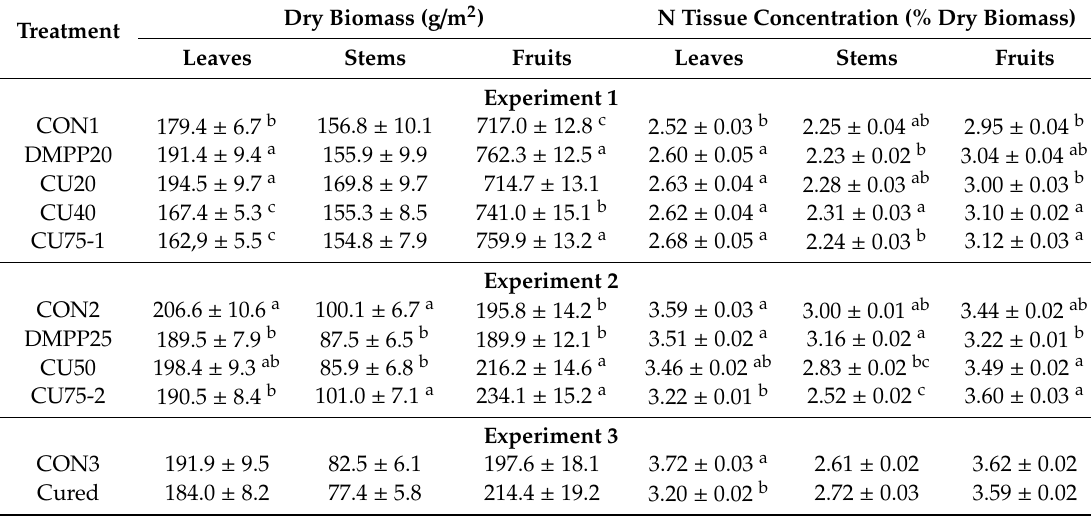
Table 5. The influence of di ff erent fertilization strategies on the distribution of biomass and nitrogen in tomato